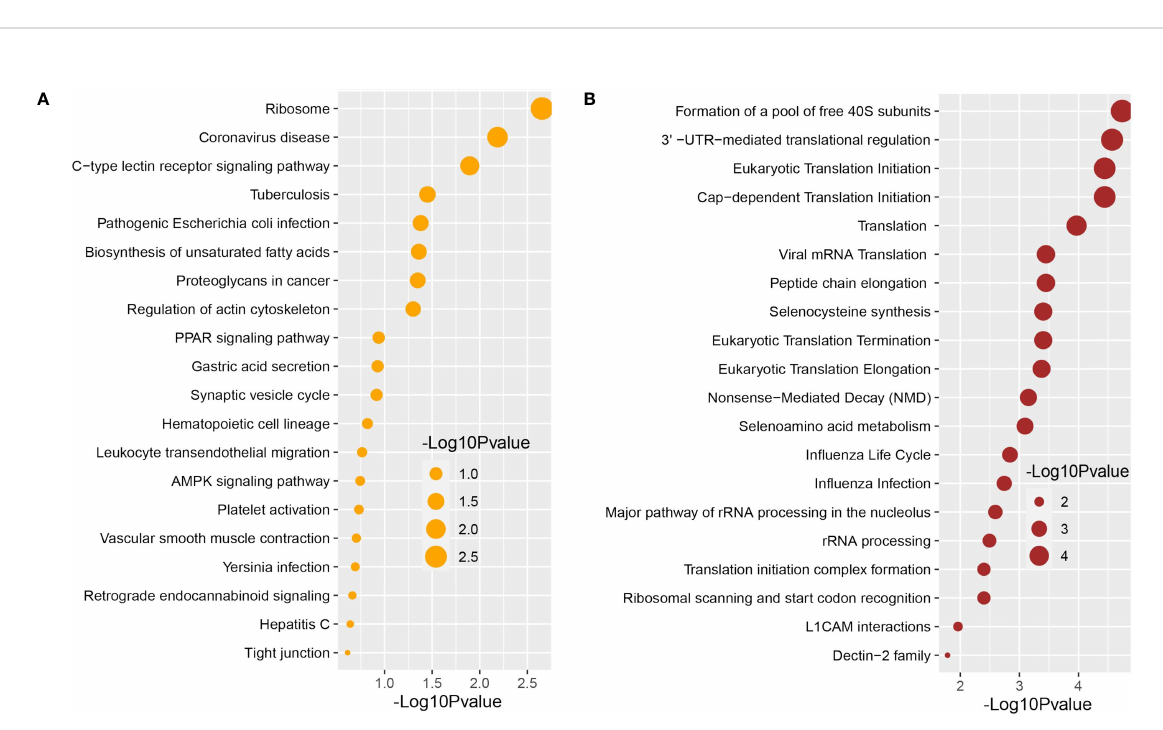
FIGURE 4 Signaling pathway analysis of nasopharyngeal epithelial cells on COVID-19 patients. We fi nd that the top 20 terms depend on the P -value. (A) KEGG pathway and (B) Reactome